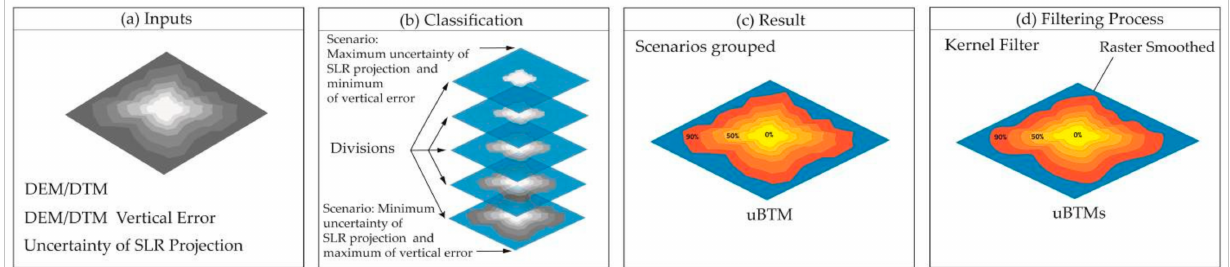
Figure 2. ( a ) Model inputs: Digital Elevation Model (DEM)/Digital Terrain Model (DTM) in raster format, vertical error of DEM/DTM, and uncertainty of sea-level rise (SLR). ( b ) ClasScheme 0. Named uncertainty Bathtub model (uBTM). ( c ) Result: all scenarios grouped into a single raster classified from 0% to 100% named uBTM. ( d ) Filter process (optional) is applied a Kernel filter on uBTM creating a smoothed uBTM